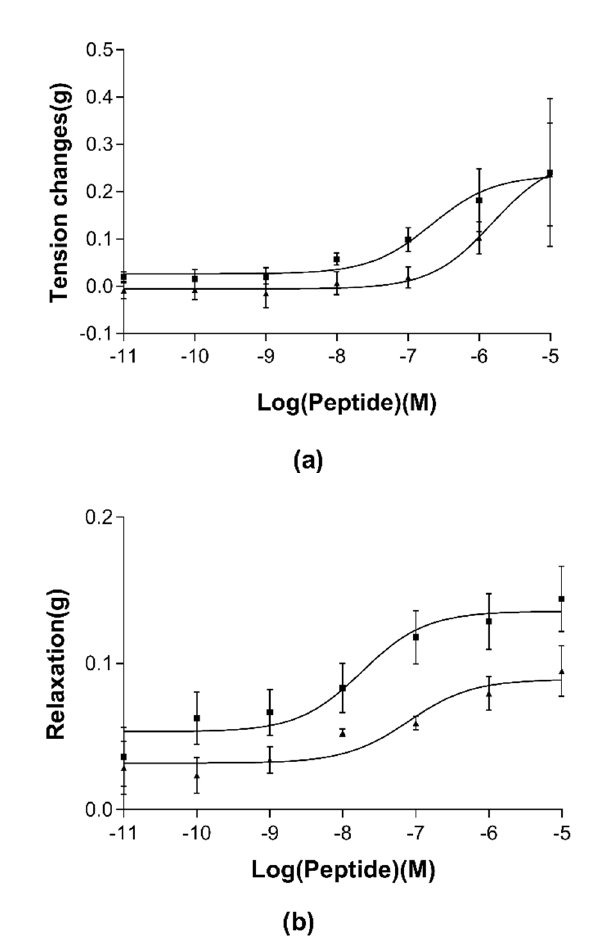
Figure 6. Dose-response curves of contraction effect on rat ileum ( a ) and relaxation effects on a rat artery ( b ) smooth muscle preparation in the presence of bradykinin (BK) ( (cid:4) ) or the presence of BK with tail artery ( b ) smooth muscle preparation in the presence of bradykinin (BK) ( ■ ) or the presence of RR-18 ( (cid:78) BK with RR-18 ( ▲ ).